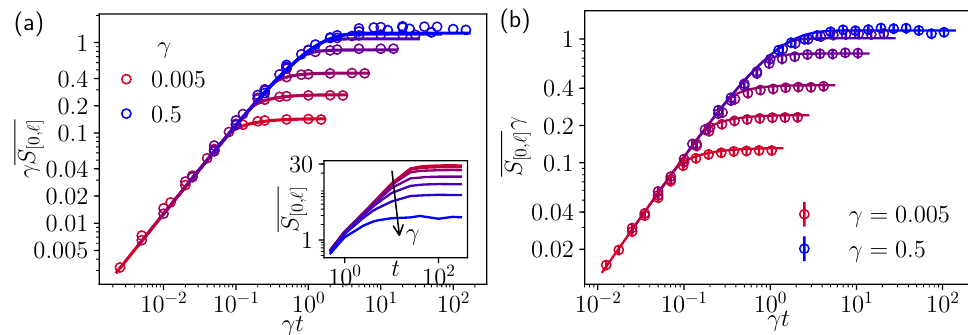
Figure 5: Growth of EE of an interval [ 0, (cid:96) ] , (cid:96) = 32 in a chain of size L = 512, with measurement rates γ = 0.005,0.01,0.02,0.05,0.1,0.5 (from red to blue). The data points are numerical results, the curves are the prediction (36). The main plots highlight the short-time scaling form (37). The inset plots the same data in naïve units. The initial states are (a) Néel state (10) with n = 1 n = 1 3